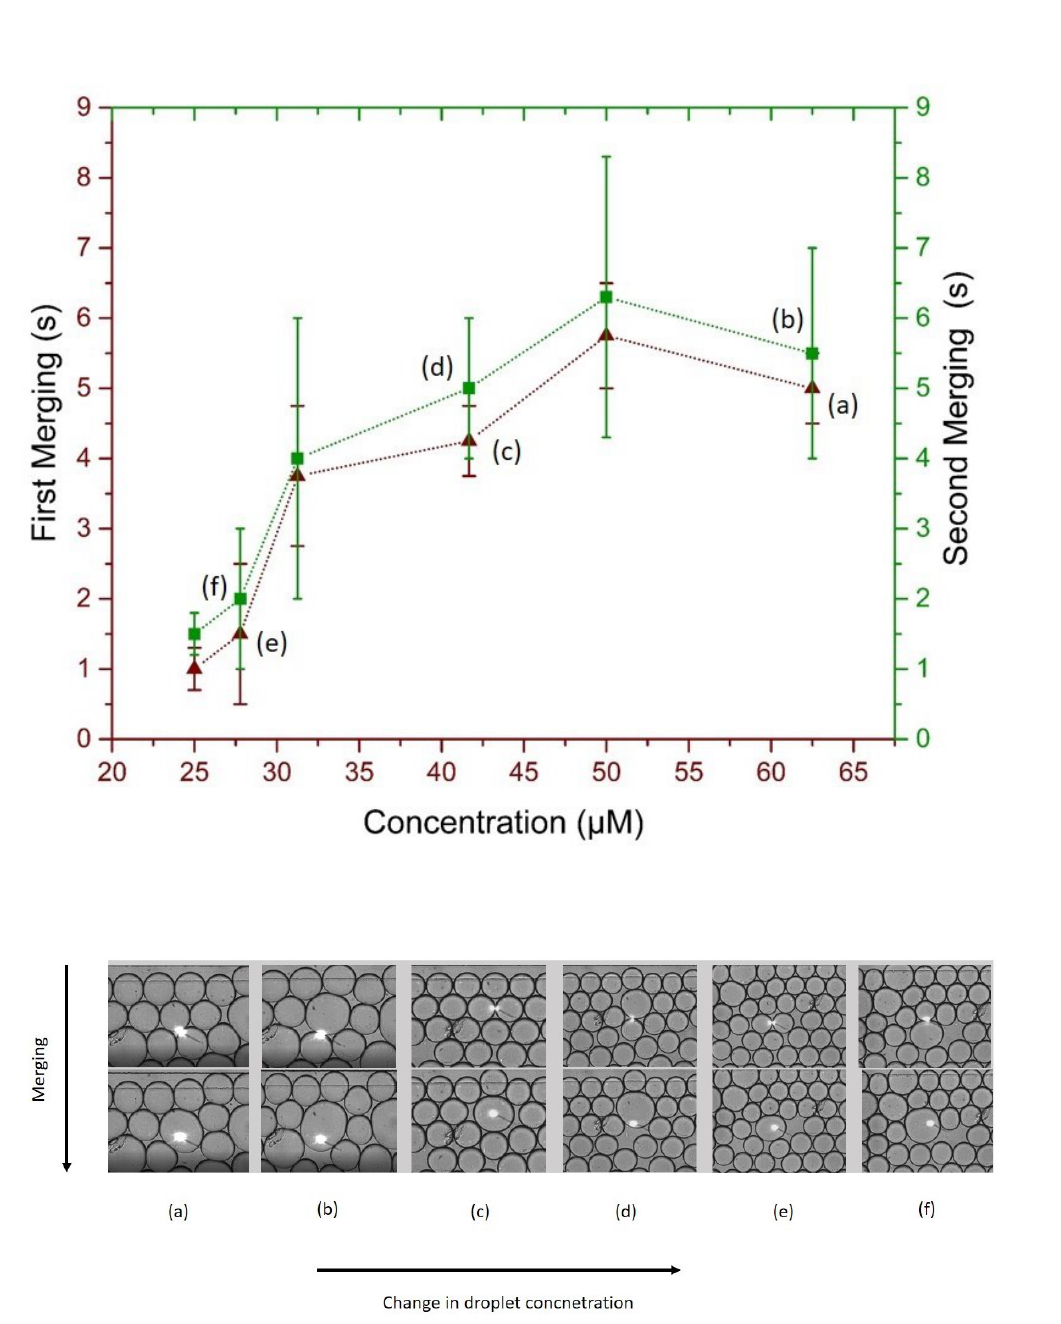
Figure 7. ( Upper ) Merging time scale of irradiated droplets, maroon (triangles) for first merging and green (squares) for second merging, ( Bottom ) optical micro-graphs of the first and second merging and resulting change in targeted droplet